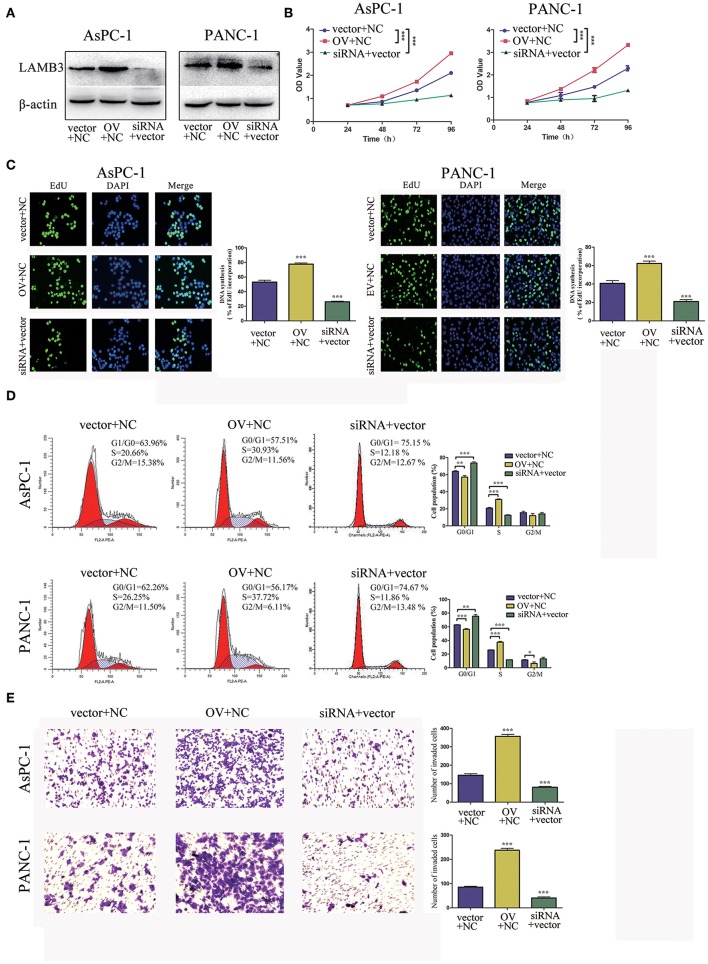
LAMB3 plays important roles in PDAC progression. (A) LAMB3 expression levels were determined using Western blotting analysis in cells transfected with LAMB3 overexpression vector (OV), LAMB3 siRNA. Cells transfected with LAMB3 empty vector (EV) and siRNA NC were used as the negative controls. (B) CCK-8 assays and (C) EdU assays confirmed that LAMB3 overexpression enhanced cell proliferation, whereas LAMB3 knockdown inhibited cell proliferation. (D) Flow cytometry showed that LAMB3 overexpression accelerated the cell cycle period and that LAMB3 knockdown induced cell cycle arrest. (E) A representative summary of the metastasis assay showed that LAMB3 overexpression promoted cell invasion, whereas LAMB3 knockdown inhibited cell invasion. Data are presented as mean ± SD of three independent experiments. *p < 0.05, **p < 0.01, ***p < 0.001, student's t-test.